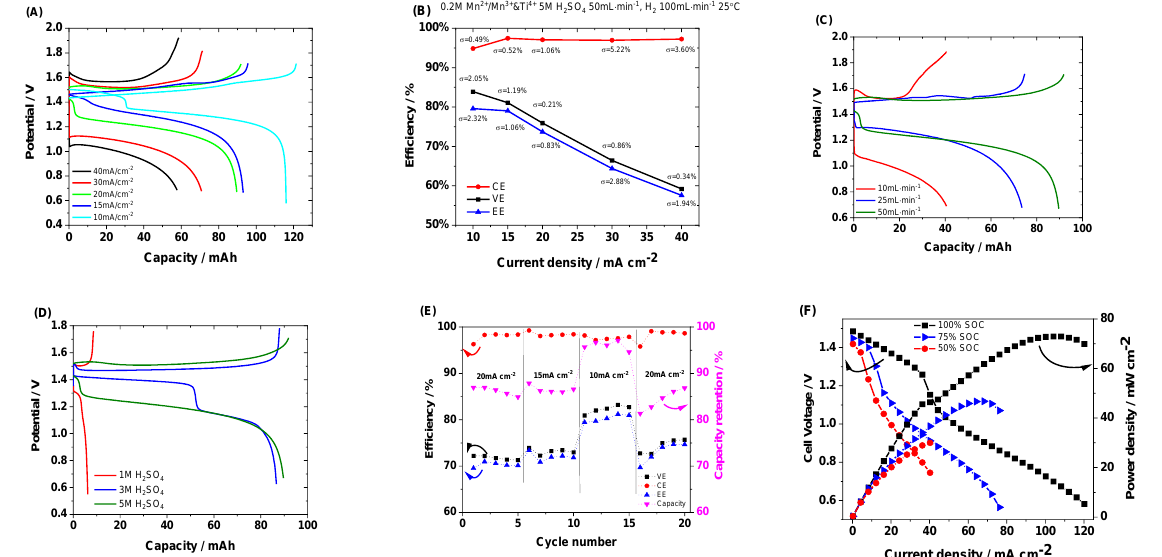
Figure 2. ( A ) Galvanostatic charge and discharge at different current densities with a single layer SGL carbon paper as a positive electrode: 10, 15, 20, 30, and 40 mA cm − 2 . ( B ) CE, VE, and EE average values over five cycles at different current densities, including standard deviation, to show variability between cycles. ( C ) Galvanostatic charge and discharge at different manganese electrolyte flow rates with a single layer SGL carbon paper as a positive electrode at 50 mA cm − 2 . ( D ) Galvanostatic charge and discharge at different supporting electrolyte concentration with a single layer SGL carbon paper as a positive electrode at 50 mA cm − 2 . ( E ) CE, VE, and EE average values over 15 cycles at different current densities (capacity utilization is also displayed). ( F ) Polarization and power density curves at a range of different states-of-charge (SOC). The electrolyte used was 1 M MnSO 4 , and 1 M TiOSO 4 in 3 M H 2 SO 4 . Hydrogen flow rate = 50 mL min − 1 , except where stated.